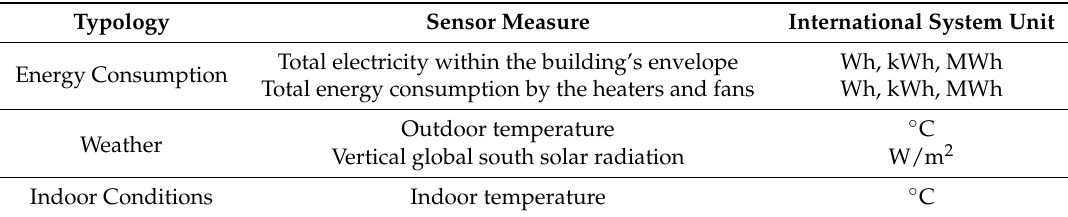
Table 5. Physical variables measured in the Co-Heating test.